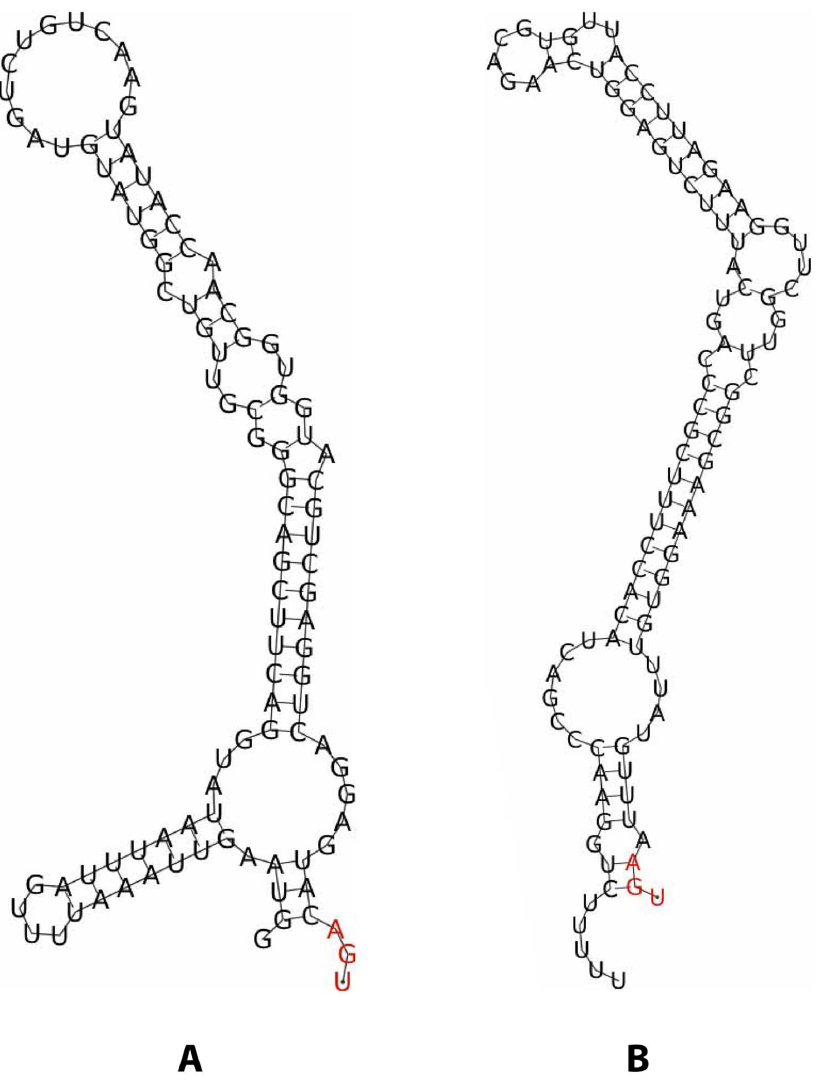
Figure 1. Potential RNA structures in C18B2.6 and SACM1L. Stop codons are highlighted in red. (a) RNA structure in C18B2.6 as predicted by RNAz. (b) RNA structure in SACM1L as predicted by RNAz.